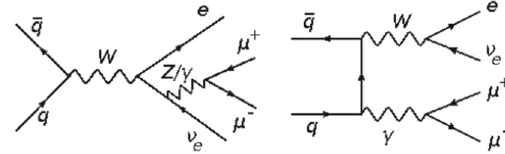
Fig. 2 Non-doubly resonant diagrams at leading